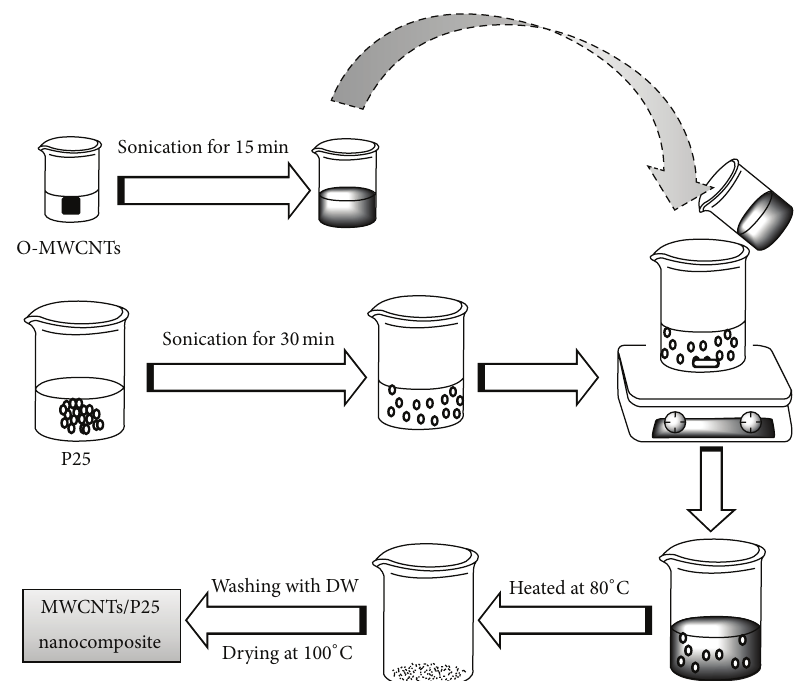
Figure 2: Schematic diagram of the experimental procedure for the preparation of the MWCNTs/P25 composite by using simple evaporation and drying process.